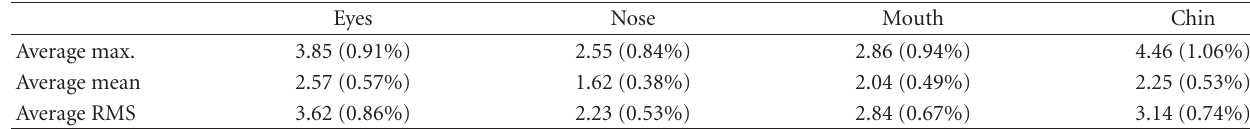
Table 3: Cross validation results of our 3D face synthesis system. Eyes Nose Chin Average max.